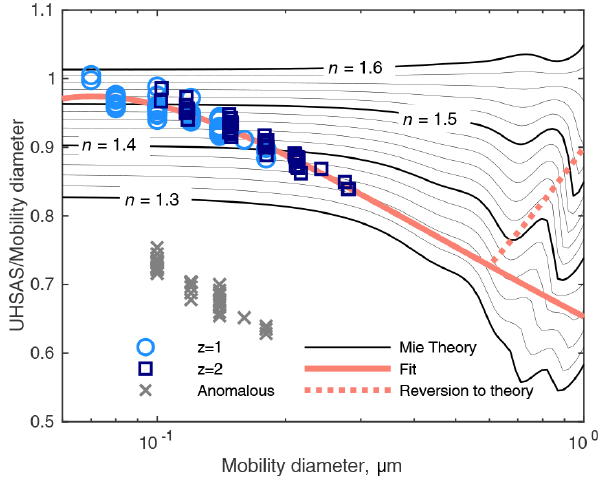
Figure 9. Particle volatility at 300 ◦ C from the thermal tandem DMA. Symbols are at the median diameter ratio before and after heating. Error bars are the 25th to 75th percentiles, encompass- ing half of the particles. Data are from all 2018 TDMA measure- ments in plume (above the MBL and with nephelometer scattering > 20Mm − 1